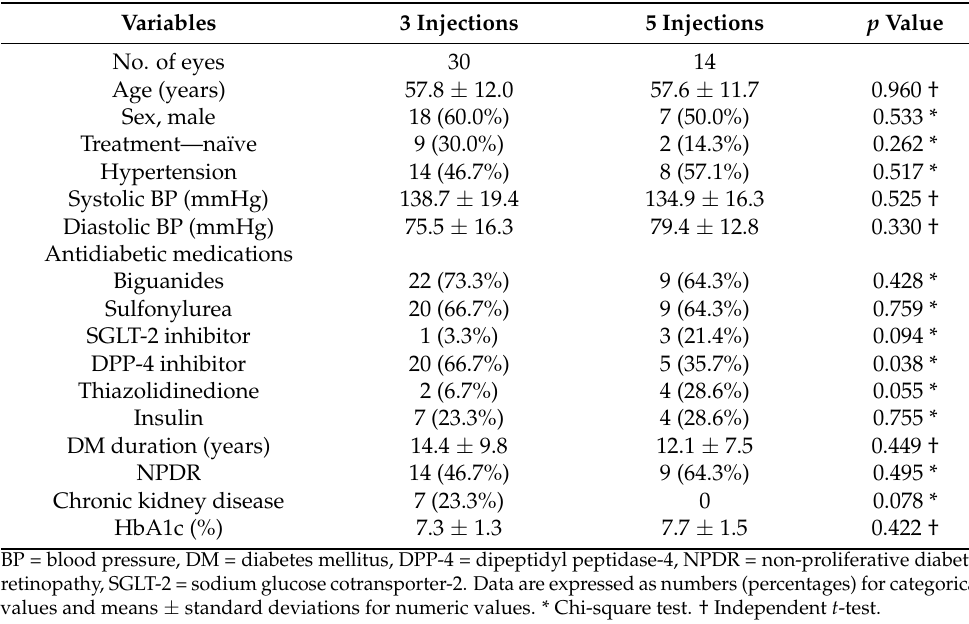
Table 1. Baseline characteristics of included patients with diabetic macular edema.